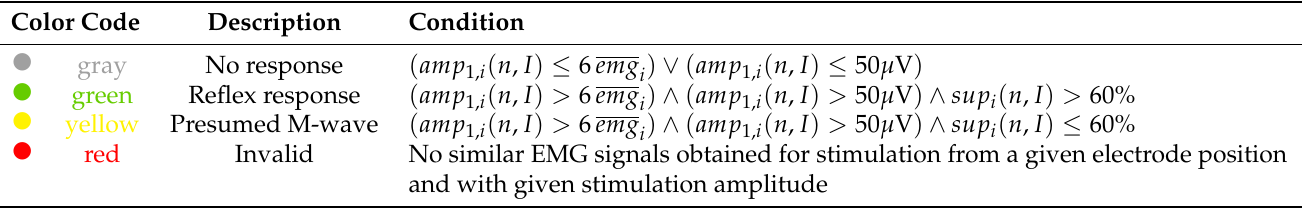
Table 2. Rating light system for the automatic evaluation of EMG responses. Color Code